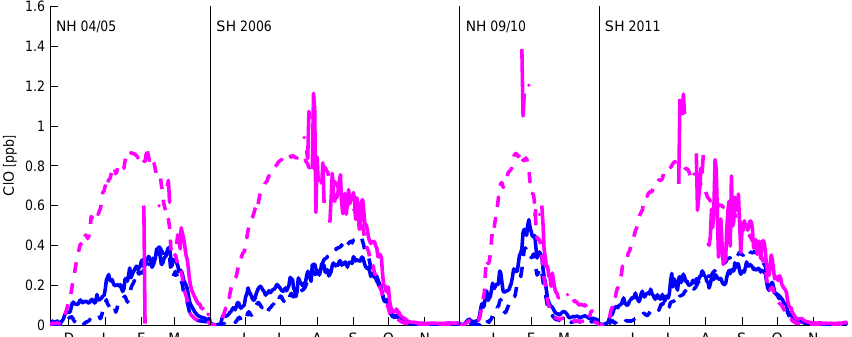
Figure 3. Vortex-averaged mixing ratio of ClO for the Arctic winter 2004/2005, the Antarctic winter 2006, the Arctic winter 2009/2010 and the Antarctic winter 011 at 54hPa. Vortex average (solid blue) and parameterization for the mixing ratio by (cid:104)[ ClO x ](cid:105)· FAS (dashed blue) and average over sunlit part of vortex (solid magenta) and parameterization for the mixing ratio by (cid:104)[ ClO x ](cid:105) (dashed magenta). Tick marks on the horizontal axis show start of months.